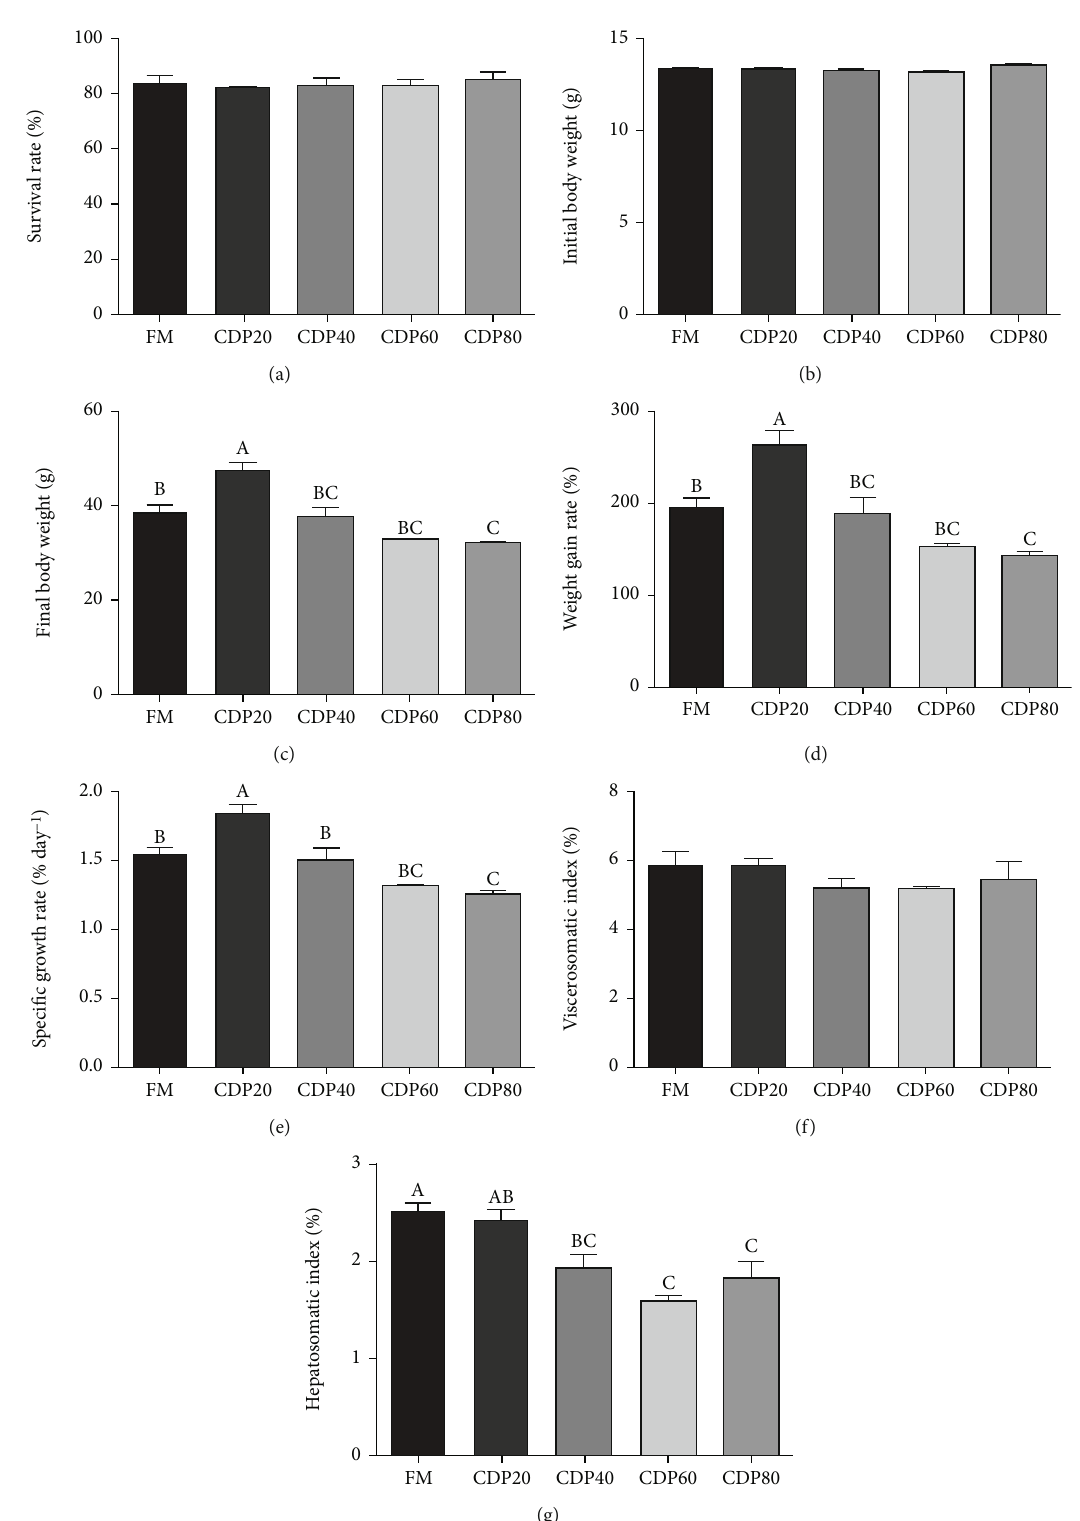
Figure 1: E ff ect of degossypolized cottonseed protein on survival rate, growth performance, and body indexes of juvenile fed the trial diets ( means ± SEM, n = 3 ). No repetition of letters in the equal index means signi fi cant di ff erences ( P < 0 : 05